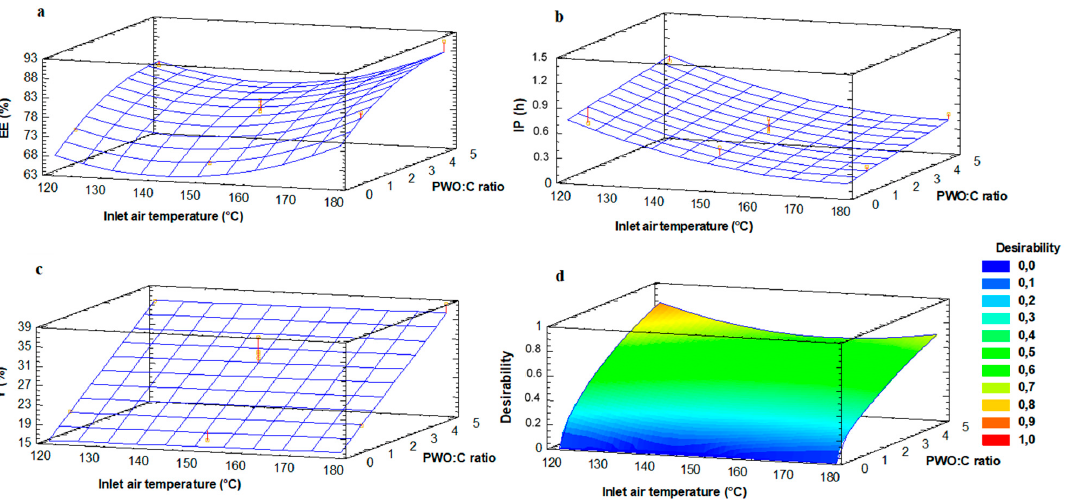
Figure 2. Response surface graphics for encapsulation efficiency (EE; ( a )), induction period (IP; ( b )), yield (Y; ( c )) and desirability function ( d ) for PWO encapsulation by spray drying.